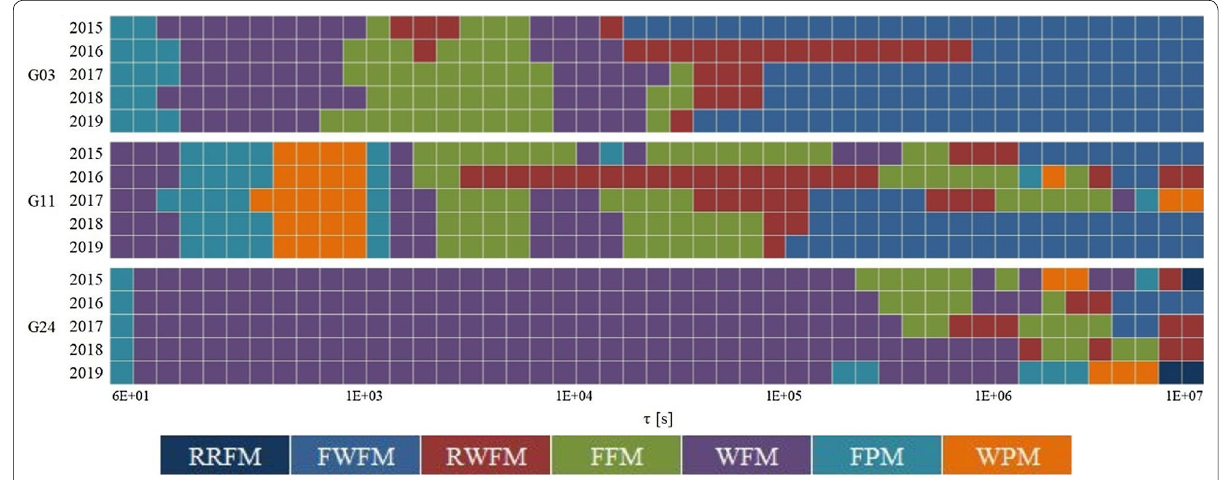
Fig. 5 Graphic representation of the noise type for 5 consecutive years (2015–2019) of analysed